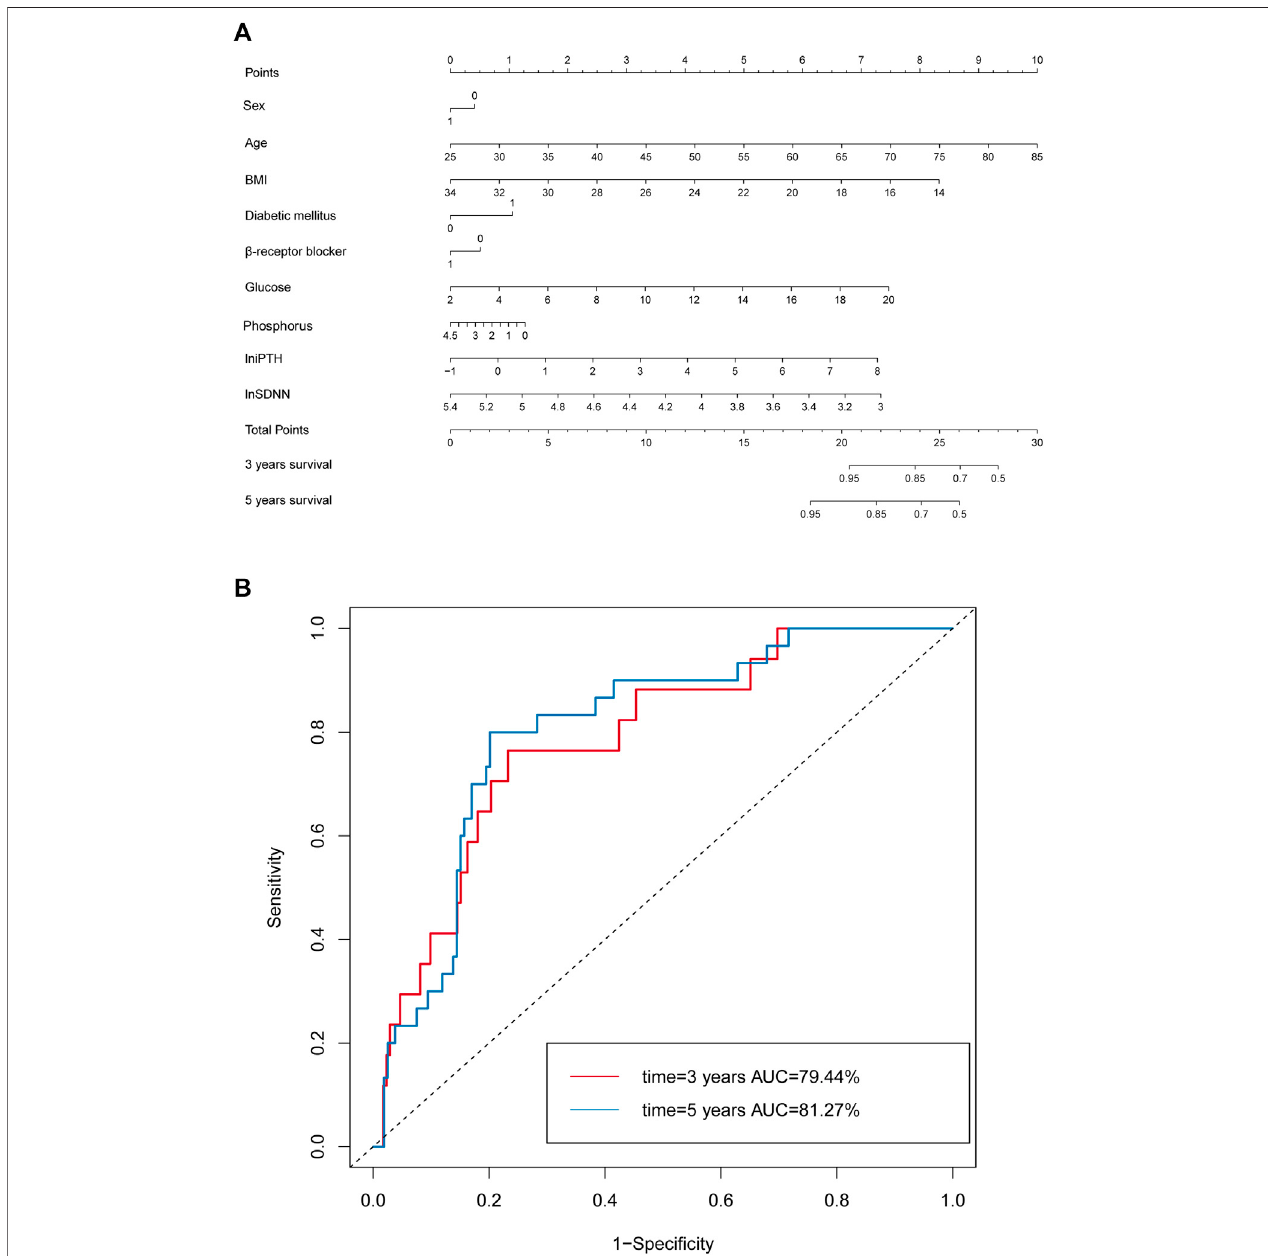
FIGURE 5 | Nomogram model based on clinical risk factors and HRV to predict all-cause mortality in CKD5 patients. (A) Nomogram model based on clinical risk factors and lnSDNN for all-cause mortality. (B) ROC validating the discriminatory power of the nomogram model for 3-year and 5-year survival rates in CKD5